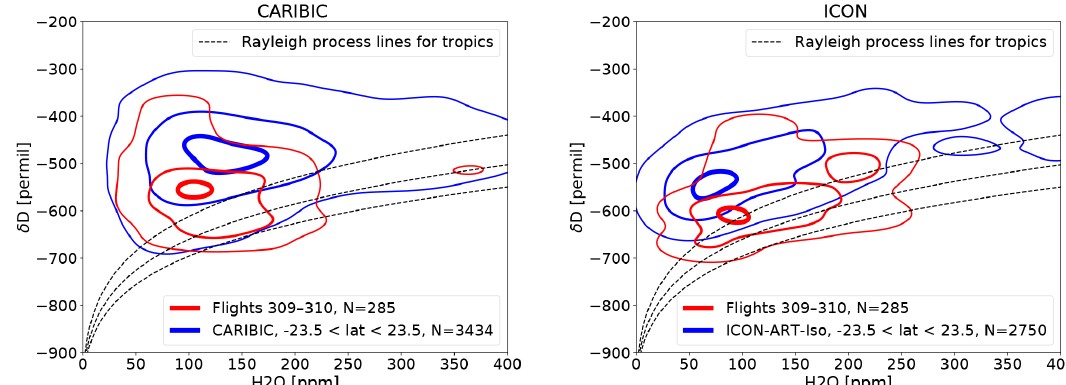
Figure 7. Isolines of the relative normalized frequency distribution (contours at 0.05, 0.4 and 0.9; see Appendix A for the method) of IAGOS- CARIBIC measurements (left) and ICON-ART-Iso model simulations for tropical samples, interpolated onto the paths of two IAGOS- CARIBIC flights 309–310 (right). The total number of data points in each distribution is given by the value N . Model data are considered only in locations with measurements, and the H 2 O measurement limit of 40ppm is also considered in model data.